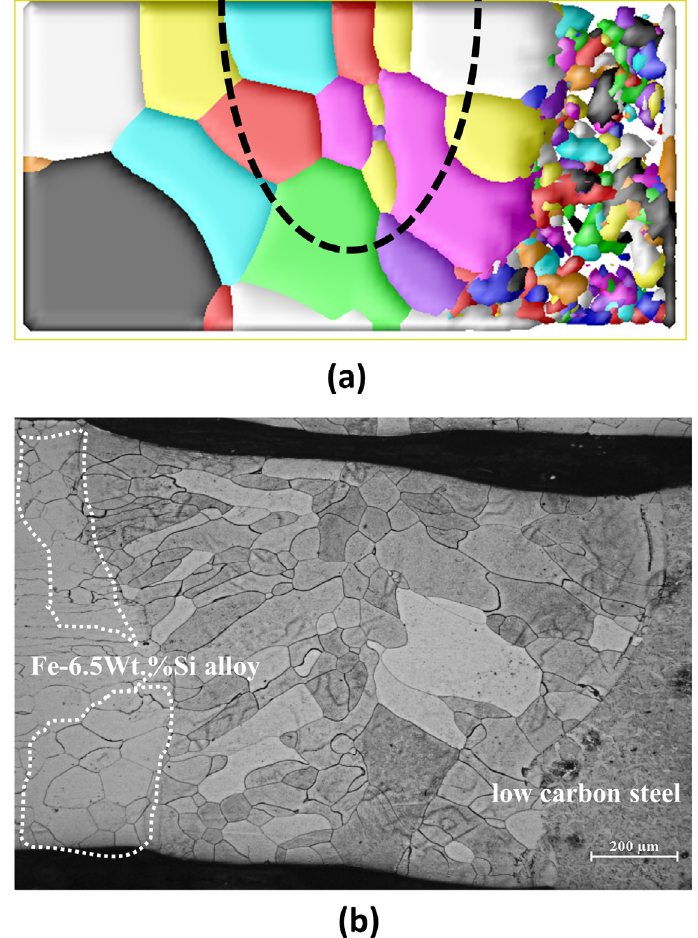
Figure 8. Comparison of ( a ) the simulated final grain structure and ( b ) the experimental results during the welding process of joining Fe–Si alloy and low-carbon steel. The different colors in the simulated grain structure represent the different orientations of the grains.